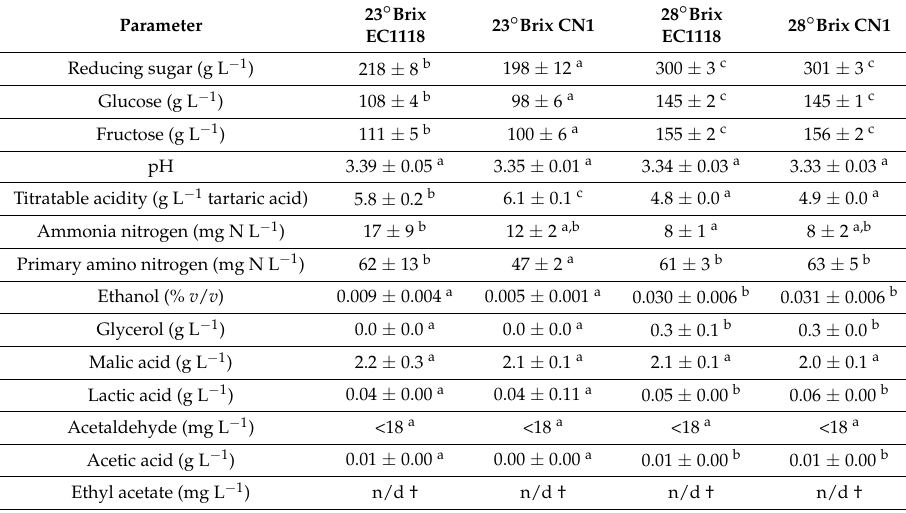
Figure 1. Soluble solid levels during fermentation. ( a ) The 23 ◦ Brix control must was inoculated with EC1118 ( ) and CN1 ( (cid:3) ); ( b ) the 28 ◦ Brix partially dehydrated grape must was inoculated with EC1118 (cid:35) ( ) and CN1 ( (cid:4) ). Data represents the mean value ± standard deviation of duplicate measurements per sample (three winemaking replicates per treatment). Table 2. Chemical composition of Cabernet franc control must (23 ◦ Brix) and must from partially dehydrated grapes (28 ◦ Brix). Data represents the mean value ± standard deviation of duplicate measurements per sample (three winemaking replicates per treatment). Lowercase letters within the same parameter indicate differences between treatments (Fisher’s Protected Least Significant Difference (LSD) 0.05 ).